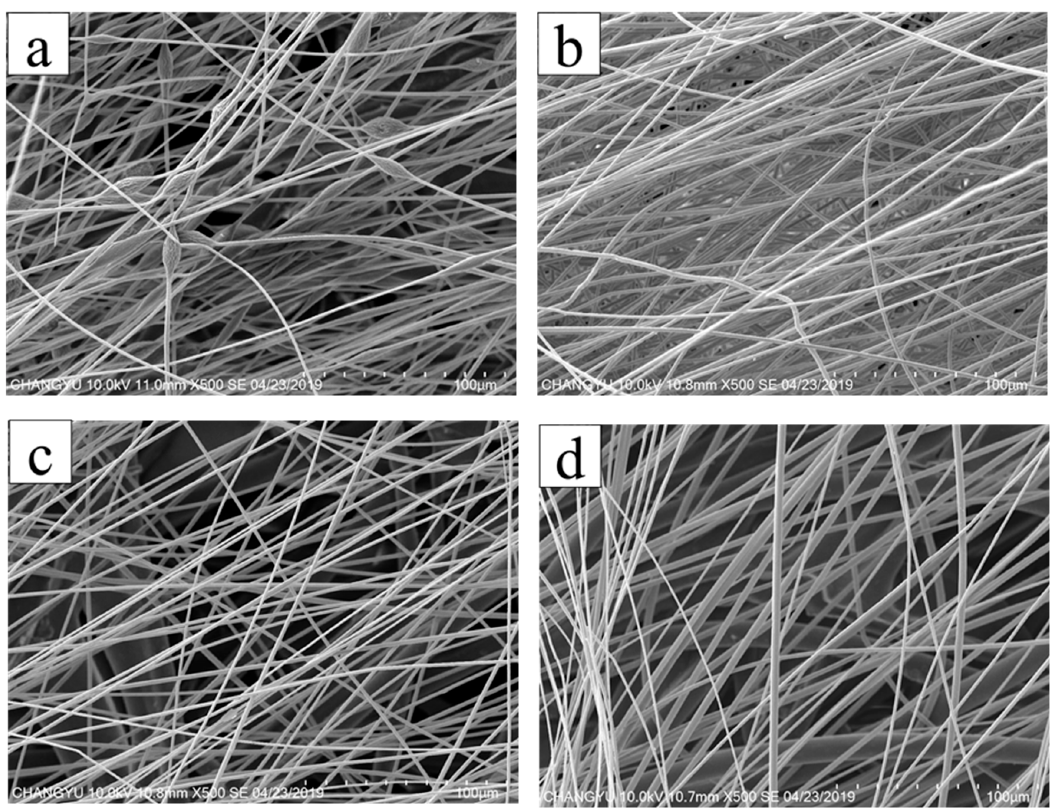
Figure 6. SEM image of the AgNPs-PS/PET composite membranes with different addition of AgNO 3 : ( a ) 0 wt%; ( b ) 0.5 wt%; ( c ) 1.0 wt%; ( d ) 1.5 Table 1. Effect of nanofiber diameter with different addition of AgNO 3.